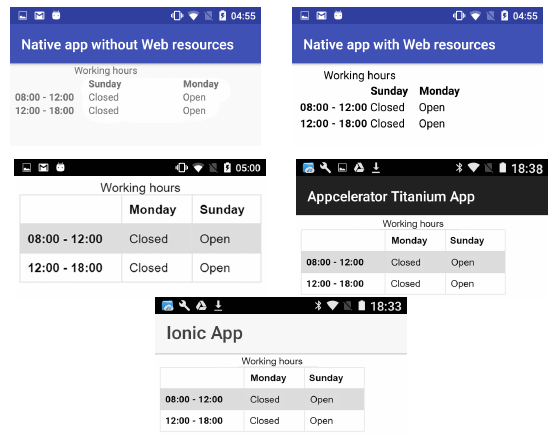
Fig. 6. Component ”external link” implemented in the native application (without Web resources), native application (with Web resources), Cordova application, Appcelerator application and Ionic application, respectively. Fig. 7. Component ”table with two headers” implemented in the native